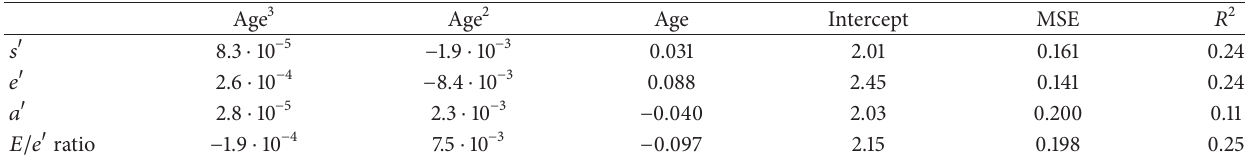
Table 4: Coefficients for regression equations relating left ventricular longitudinal indexes and age. For each index, application of the corresponding third-grade equation provides the expected logarithmic value according to age. In a patient with given age, this allows calculation of the 𝑧 score that corresponds to the observed value of the index in that patient (see text).